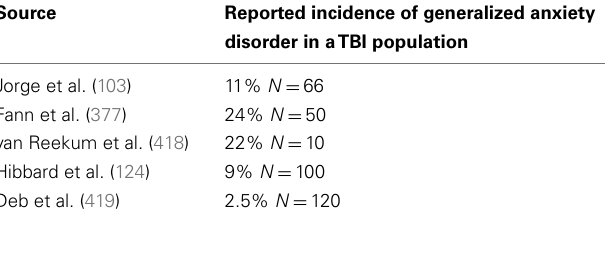
Table 10 | Incidence of generalized anxiety disorder in aTBI